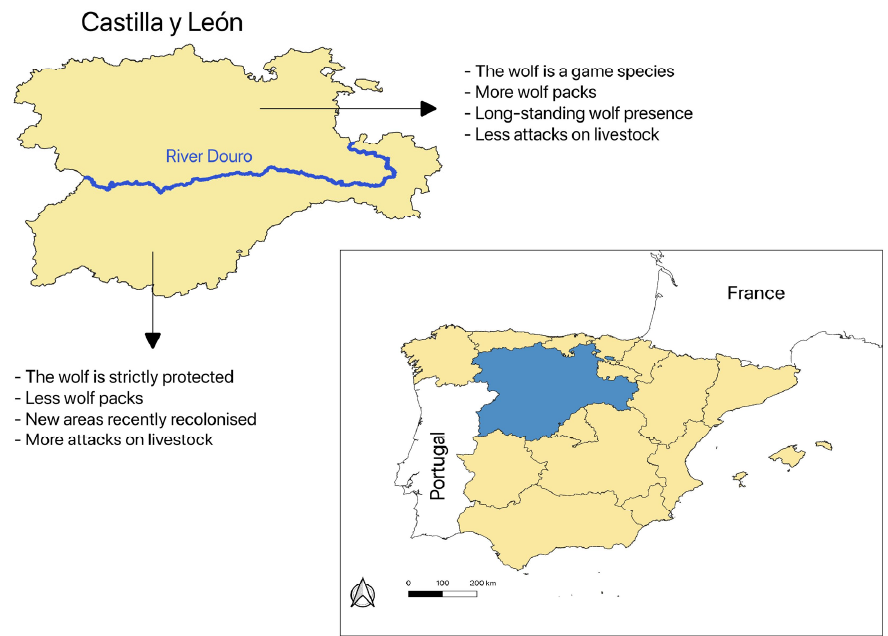
Figure 1. Location of the Castilla y León region in northern Spain. The River Douro divides the region in two sub-regions with highly contrasting situations in terms of wolf management, policy, and ecology.